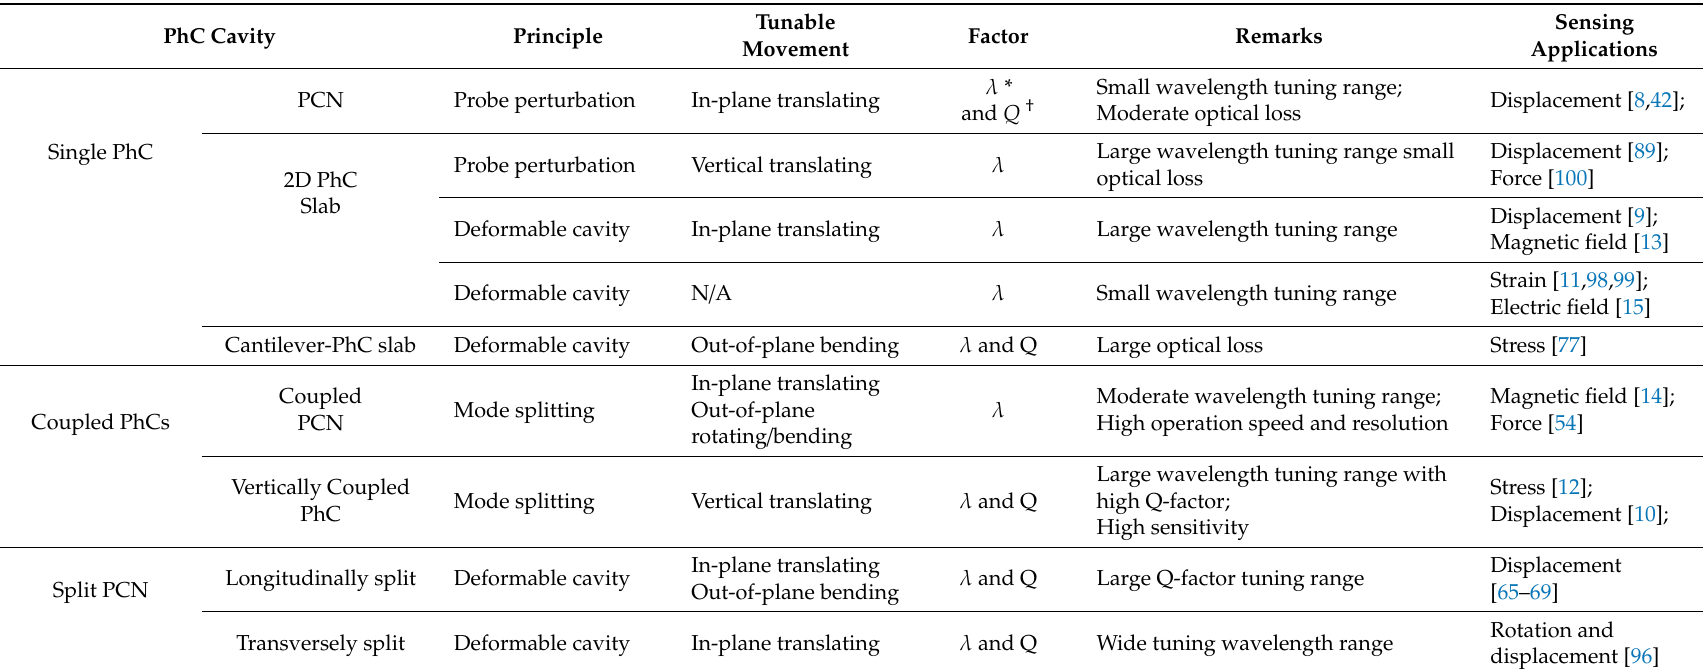
Table 3. Comparison of sensing applications based on mechanically tunable PhC